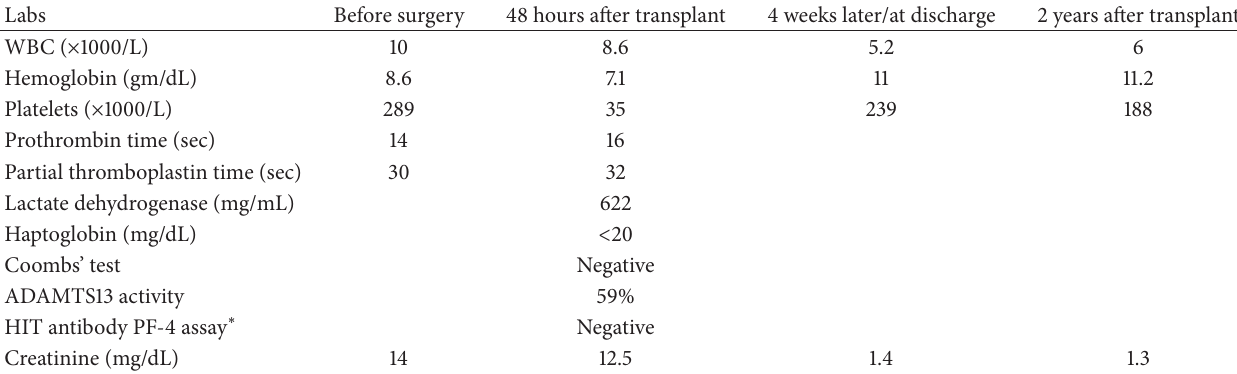
Table 1: Pertinent laboratory values of the second patient describing the postoperative clinical